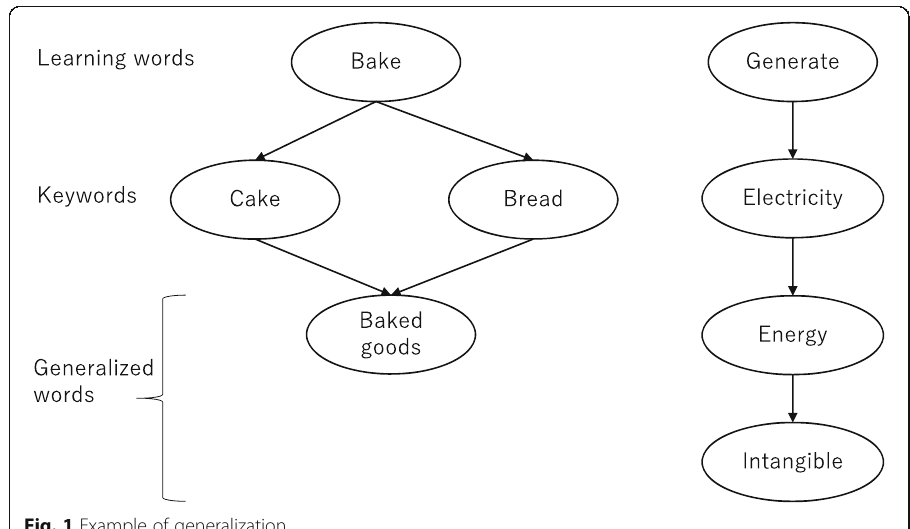
Fig. 1 Example of